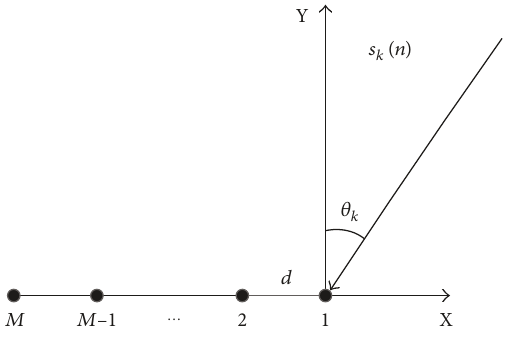
Figure 1: Illustration of the array